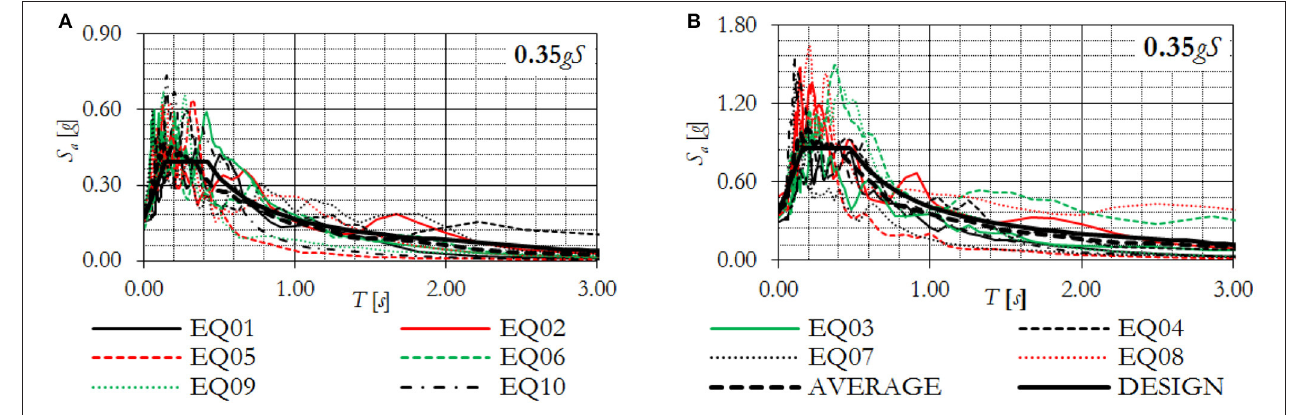
FIGURE 24 | Design spectrum-compatible earthquake records at the (A) damage limit state (DLS) and (B) life safety limit state